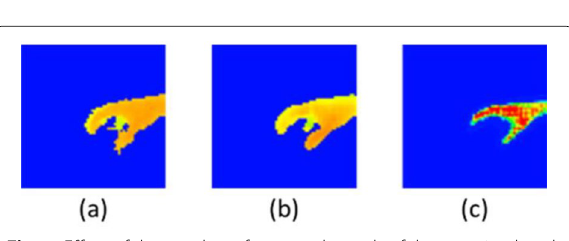
Fig. 4 Effect of the number of output channels of the grasping hand shape network. a the correct hand shape, b the estimation result by the two-channel output network, c the estimation result by the one channel output network